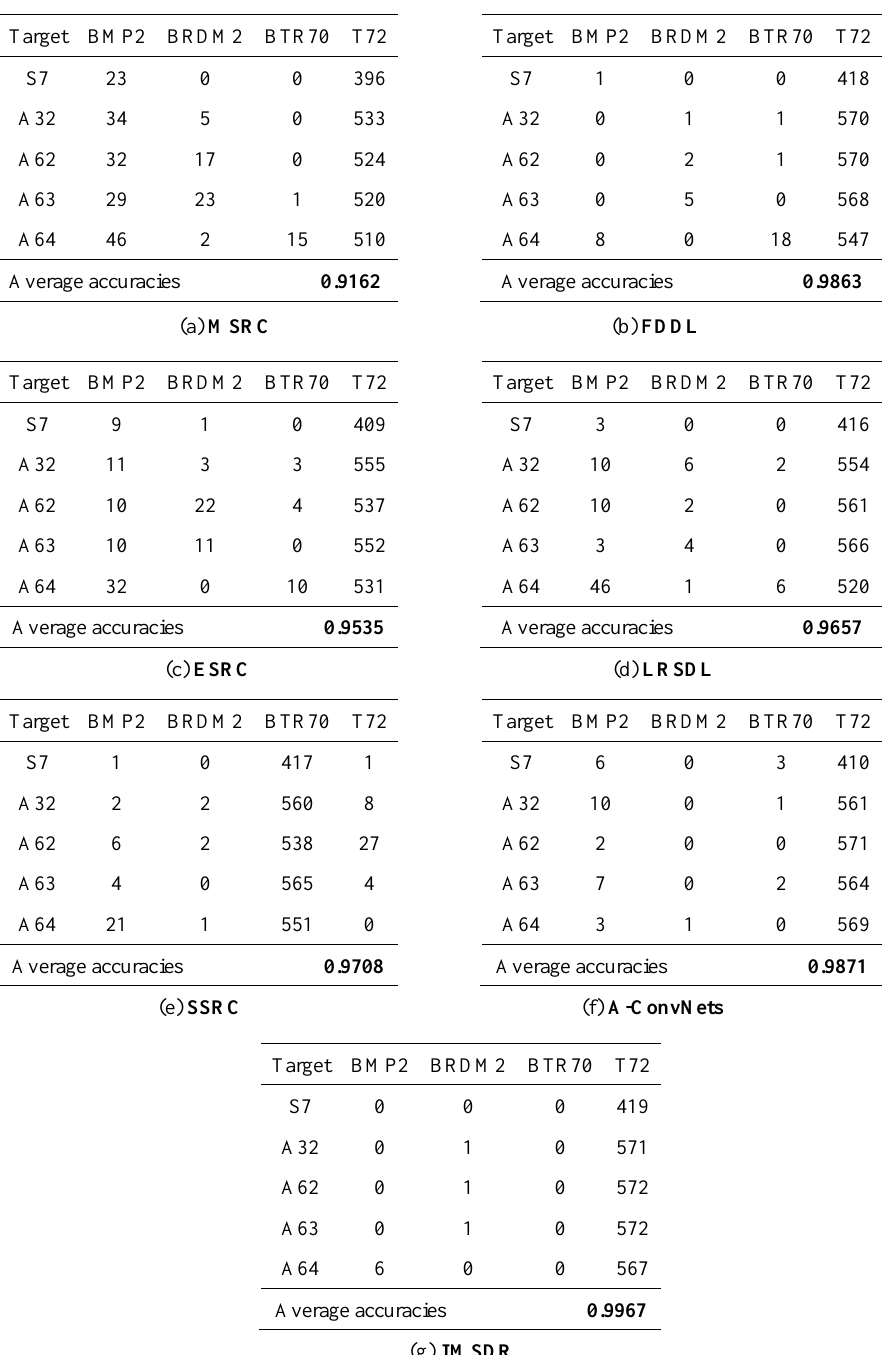
Figure 8. The confusion matrices of MSRC, FDDL, ESRC, LRSDL, SSRC, A-ConvNets and JMSDR under version variants